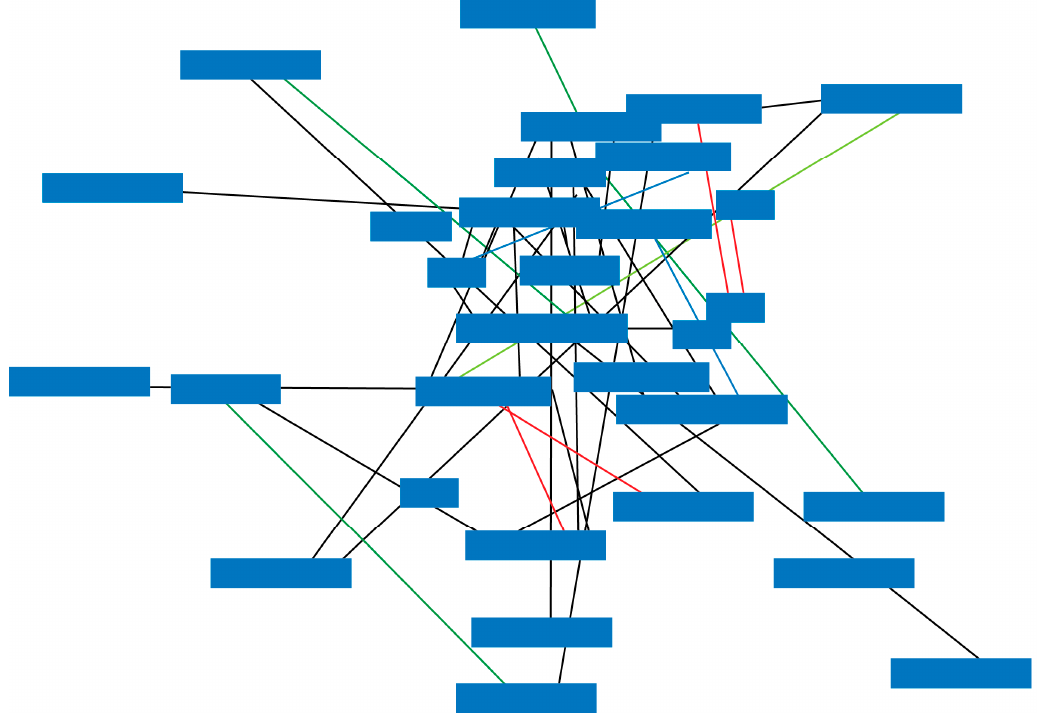
Figure 3. Cohere concept network (showing complexity of network).